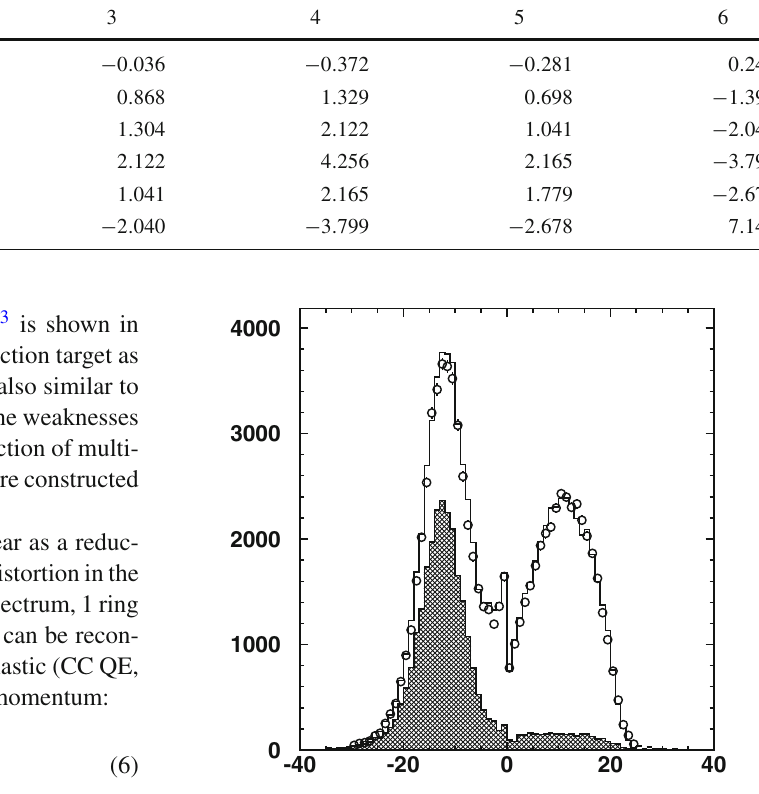
for an event for data. Events that have a charge less than 200 photo-electrons (p.e.) are considered as Fully Contained (FC) events. The rest are partially contained (PC) events, because exiting particles emit Cherenkov light near the PMT around the exit point, which is likely to produce a large amount of light recorded by one PMT. Figure 24 shows the selection efficiency between all fiducial volume events and FC1R μ events as a function of